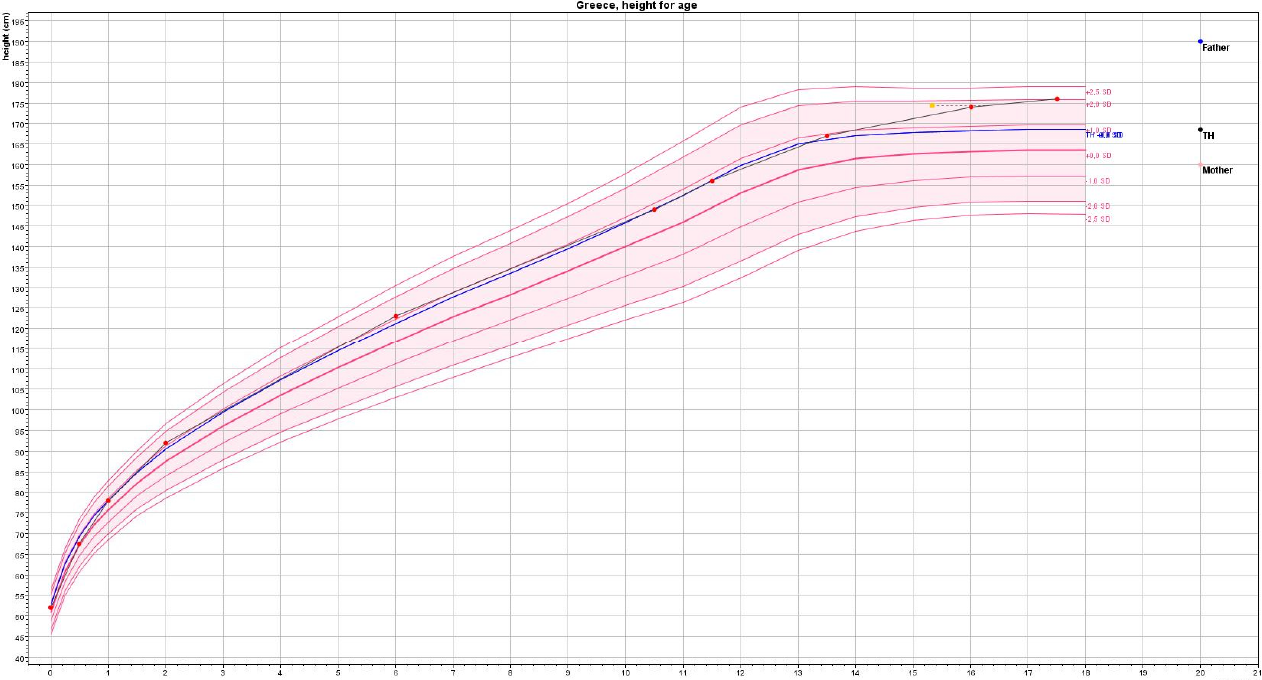
Figure 1. Growth chart; Growth Analyser© 2022–2006, Rotterdam—The Netherlands. On examination, she was normotensive. There were no dysmorphic features. Her breast development was Tanner stage III, her pubic hair was Tanner stage II (sparse fine hair on pubic area), and her axillary hair was Tanner stage II (sparse fine hair). She had normal female external genitalia with no signs of virilization.